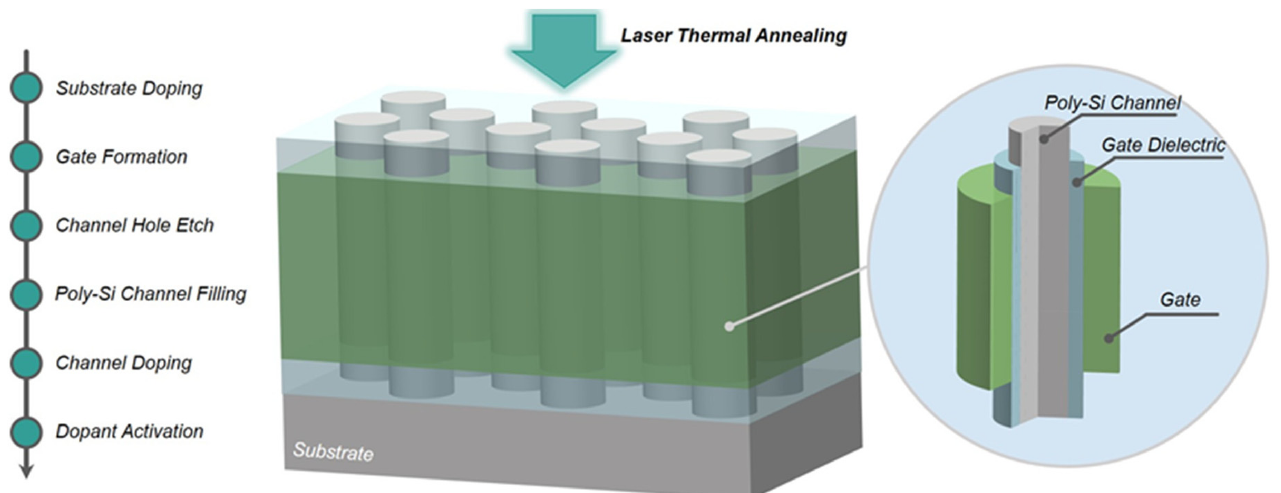
Figure 1. The main fabrication steps of the vertical channel transistor test structure. The schematic diagram of laser thermal annealing vertical channel transistors array. The inset shows the detailed structure of the vertical channel